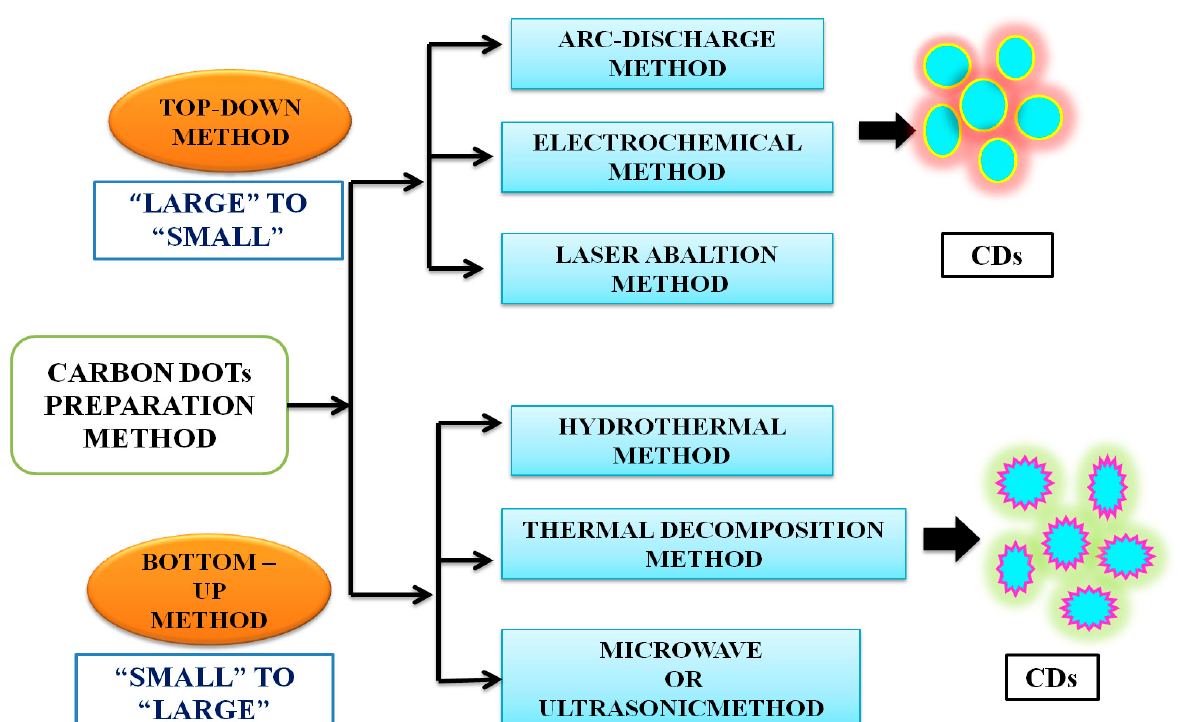
Figure 3. Common top-down and bottom-up approaches to synthesize carbon dots. The details of these methods are available in recent